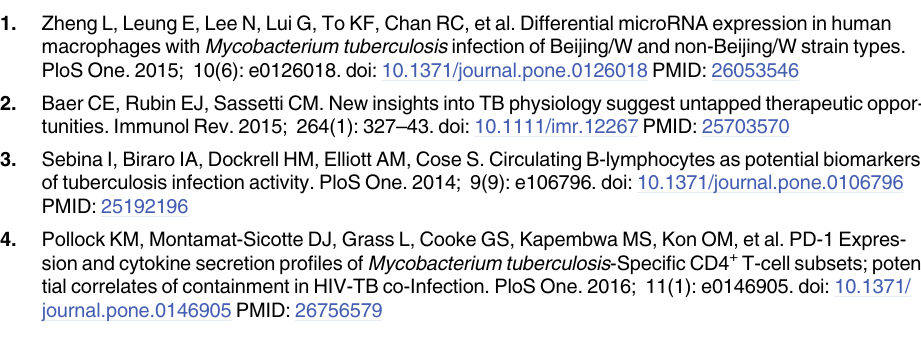
S1 Fig. Flow cytometric analysis of the purity of isolated B cells. PBMCs before (A) and after (B) isolation of B cells. (TIF) S1 Table. Positional relationship between lncRNA and the adjacent protein-coding genes.